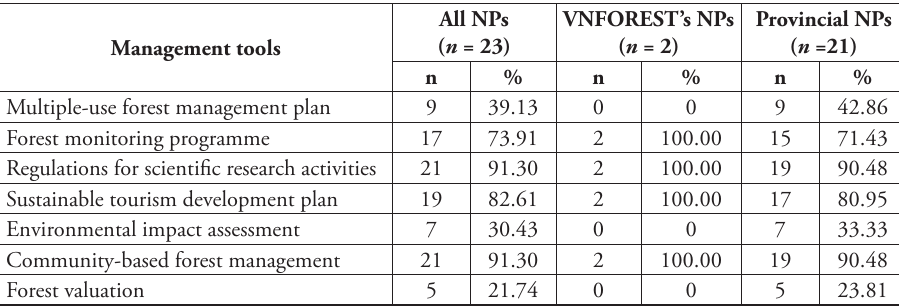
Table 2. The national park management plan updated by other management